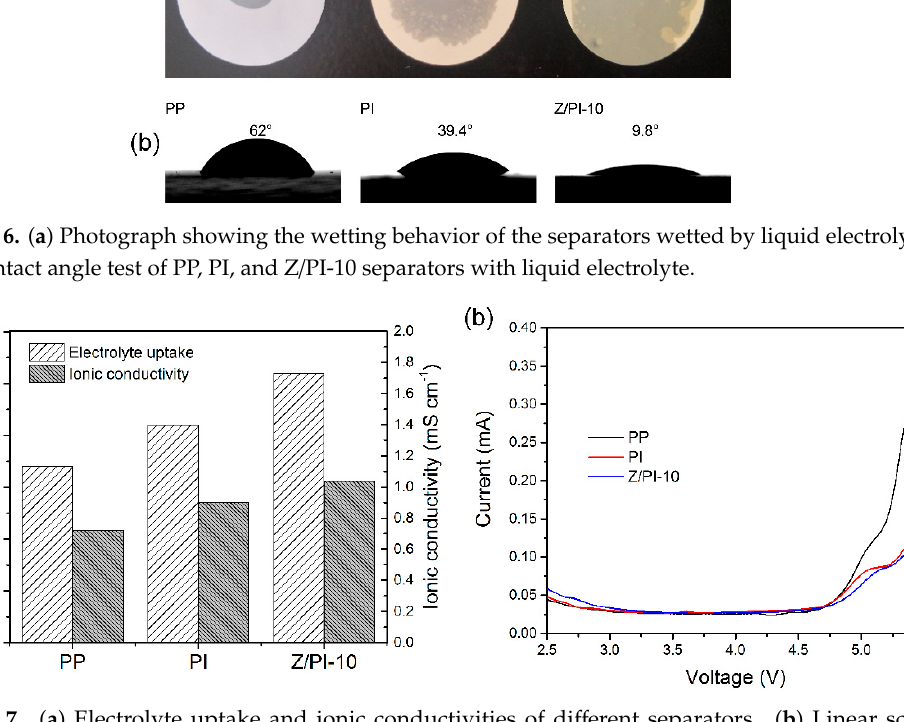
Figure 7. ( a ) Electrolyte uptake and ionic conductivities of different separators. ( b ) Linear scan voltammograms (LSV) curves of different separators.